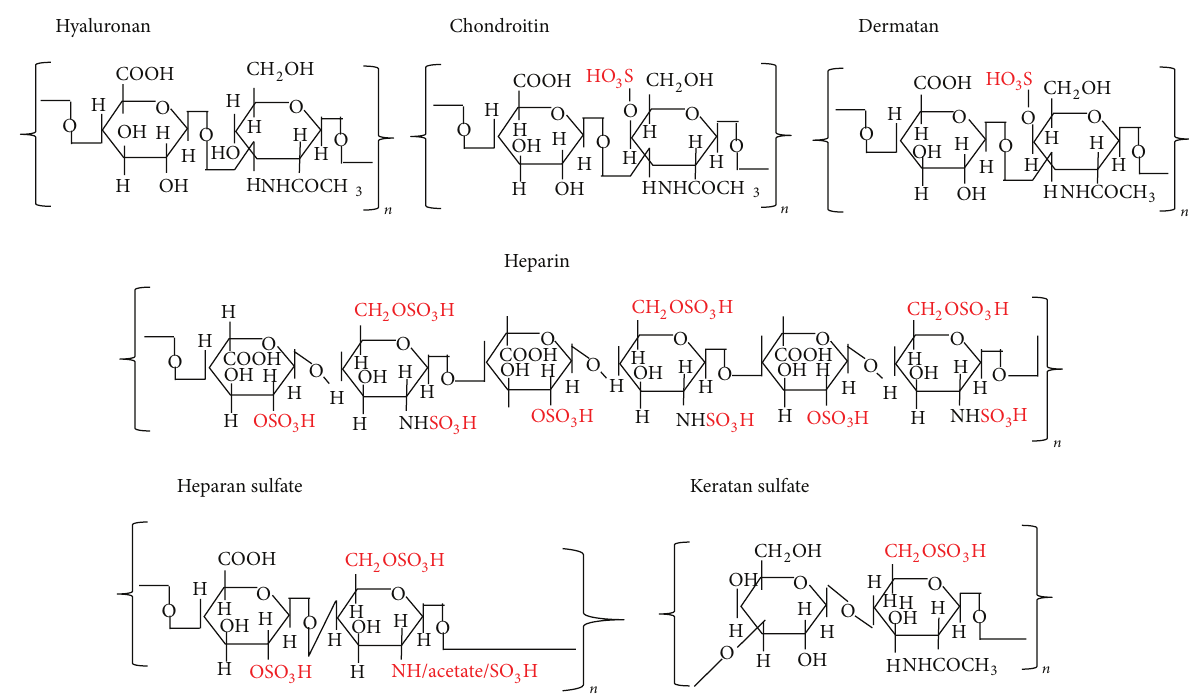
Figure 3: Structures of repeating disaccharides of